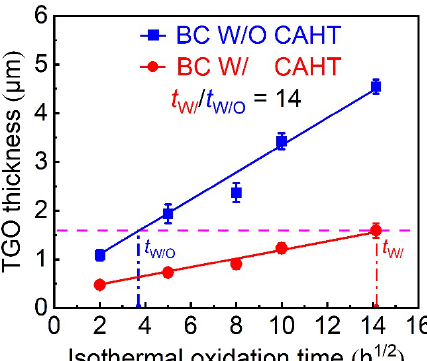
Fig. 37 Comparison between the growth rate of the heat-treated bond coat and the as-sprayed bond coat. Reproduced with permission from Ref. [195], ©